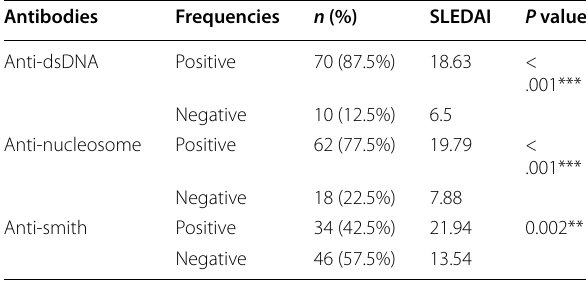
Table 3 Comparison of the SLEDAI score between positive